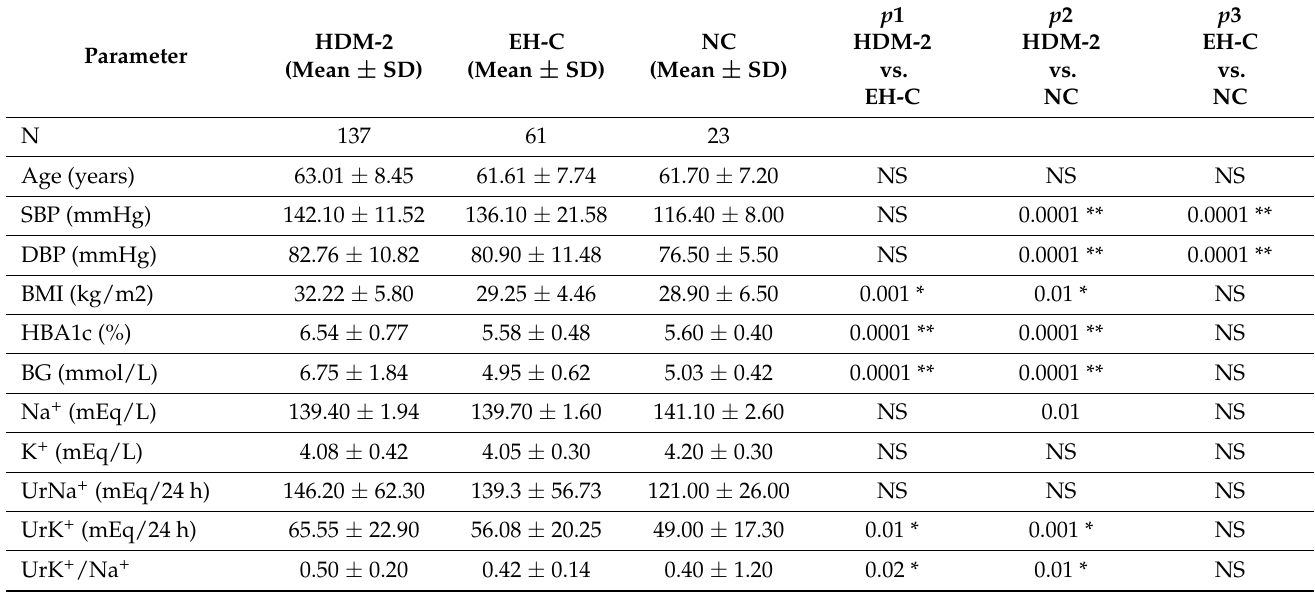
Table 1. Anthropometric characteristics and biochemical parameters of all hypertensive patients with DM-2 (H-DM-2), patients with essential hypertension (EH-C), who were used as controls for DCVT, and normotensive individuals used as controls in the ultralow ACTH test (NC).